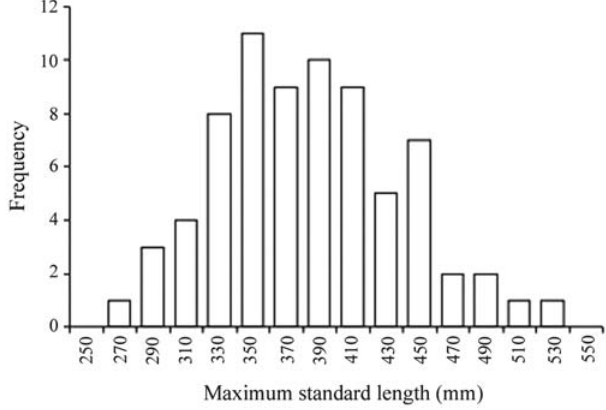
Fig. 5. Distribution of maximum standard length from 74 sampled populations (adapted from Colautti et al ., 2006).